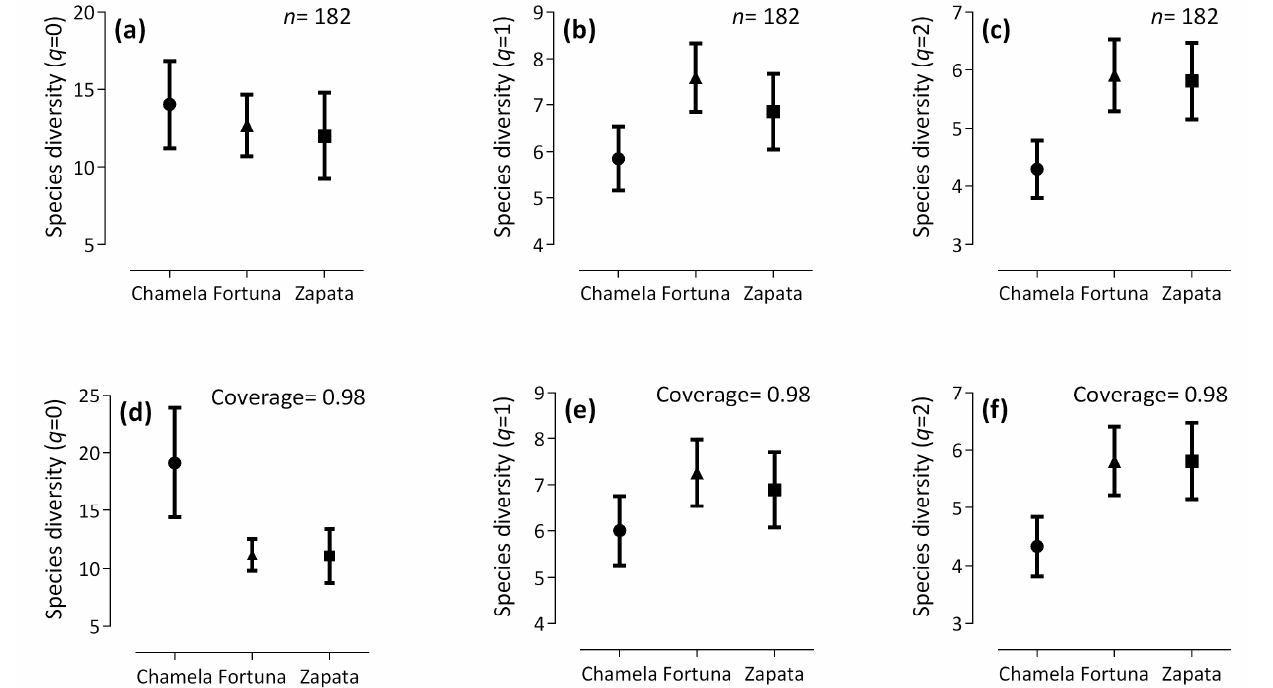
Figure 1. Diversity orders q = 0, 1, and 2 based in number of individuals ( a – c ) and sampling coverage ( d – f ) for three locations during two years of fieldwork.